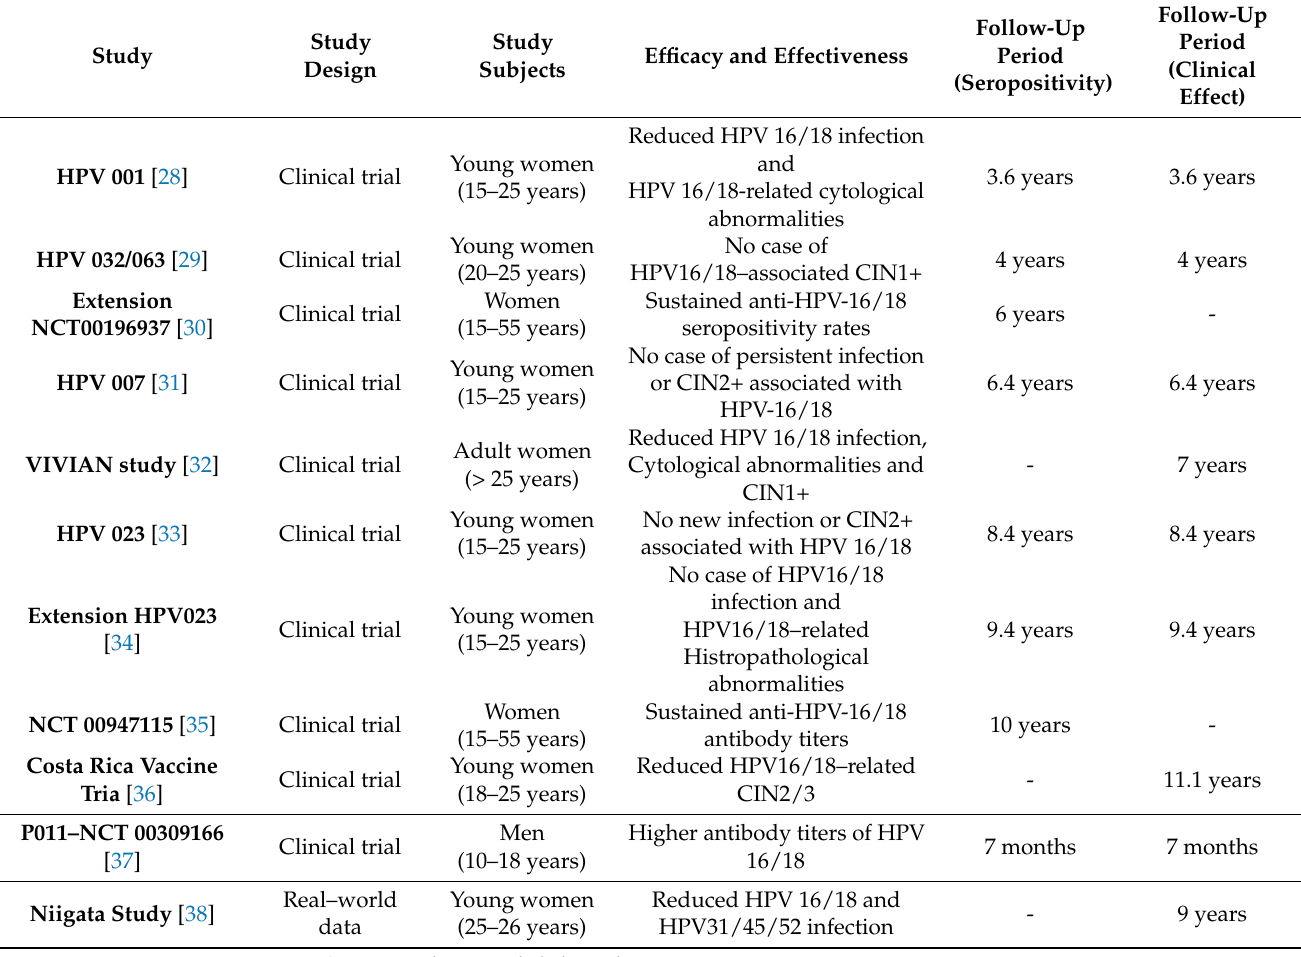
Table 2. Long-term effect on bivalent HPV vaccine.